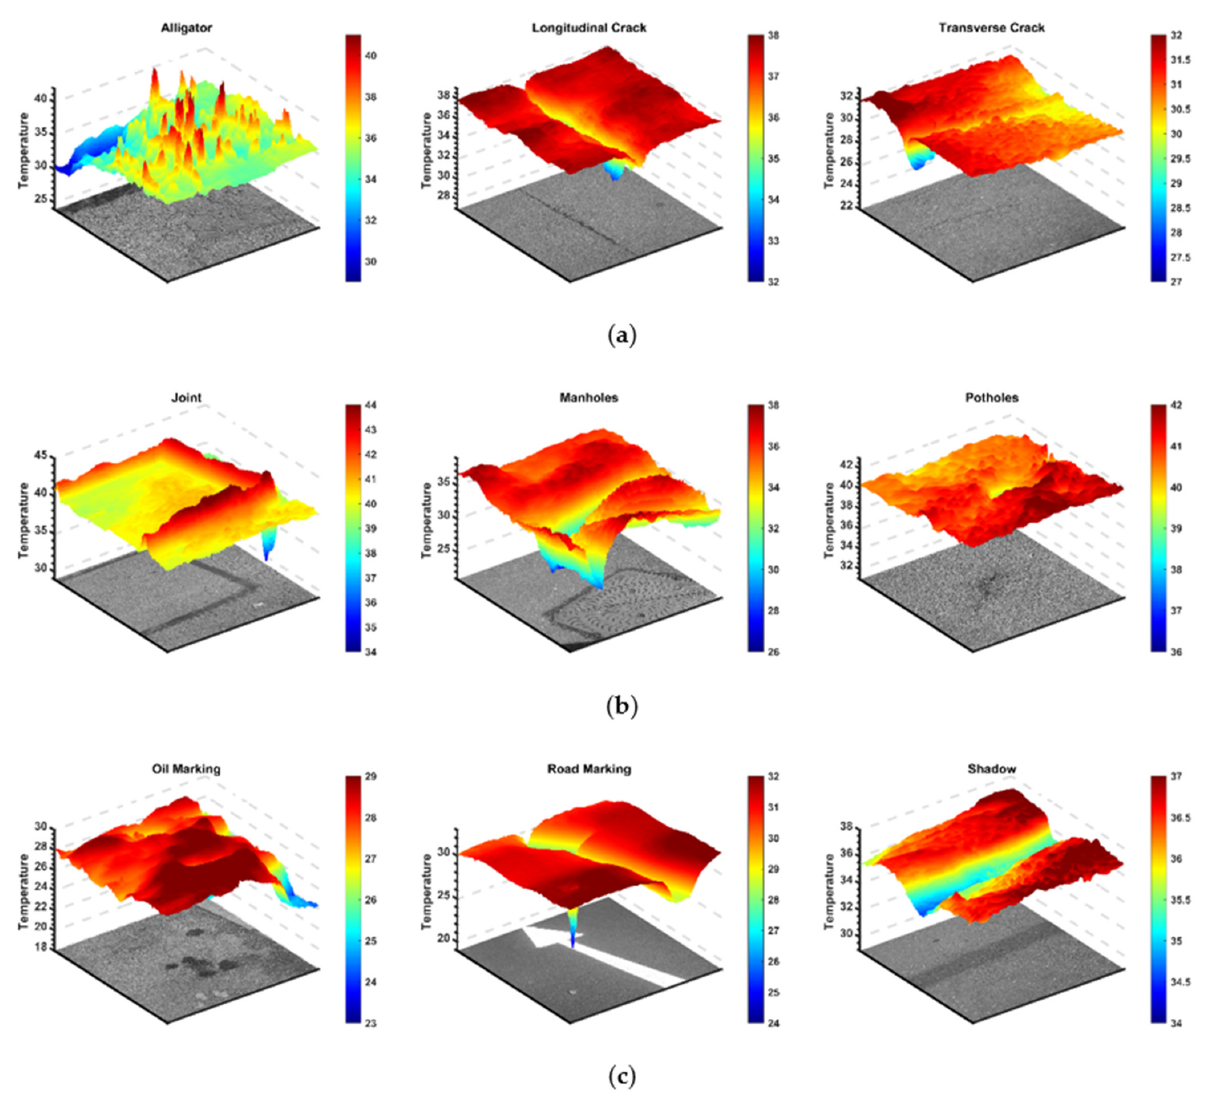
Figure 8. Optical and 3D thermal images of different pavement conditions. ( a ) 3D thermal image and RGB image of alligator crack, longitudinal crack and transverse crack. ( b ) 3D thermal image and RGB image of joint, manholes and potholes. ( c ) 3D thermal image and RGB image of oil marking, road marking and shadow.